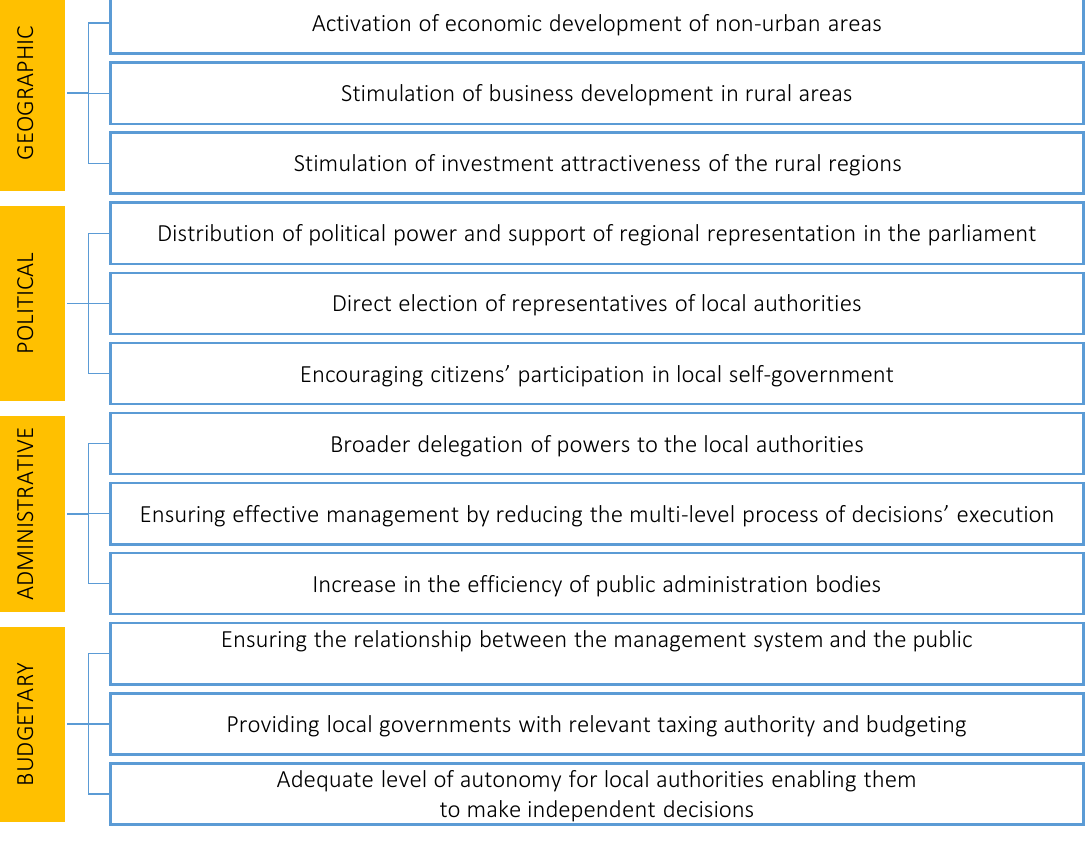
Figure 1. Types of decentralization